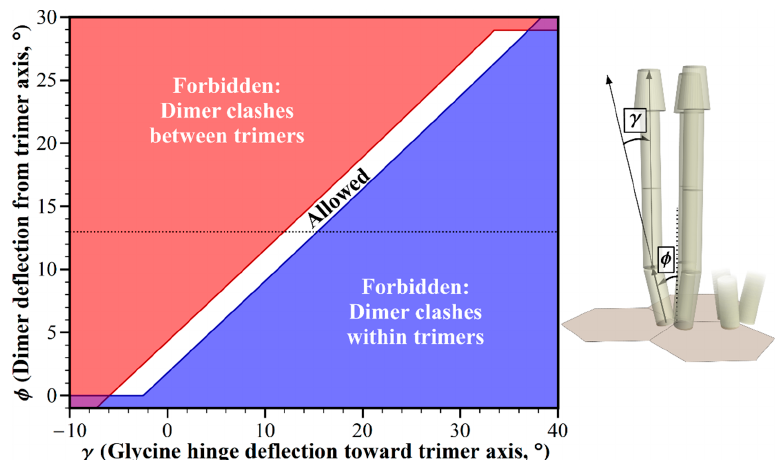
Figure 4. Geometric restrictions in core signaling complexes and their arrays as a function of dimer deflection, ϕ and glycine hinge deflection, γ . The plot shows the structural consequences of the combinations of dimer deflection from the trimer central axis, and the glycine hinge deflection toward the trimer axis. For the allowed combinations (white area), receptors fit into the available space. For any forbidden combinations, they do not, because of structural clashes between the dimers in neighboring trimers (red areas), or in the same trimer (blue areas). The 13° dimer deflection for an E. coli receptor trimer [18] is marked with a dotted line.